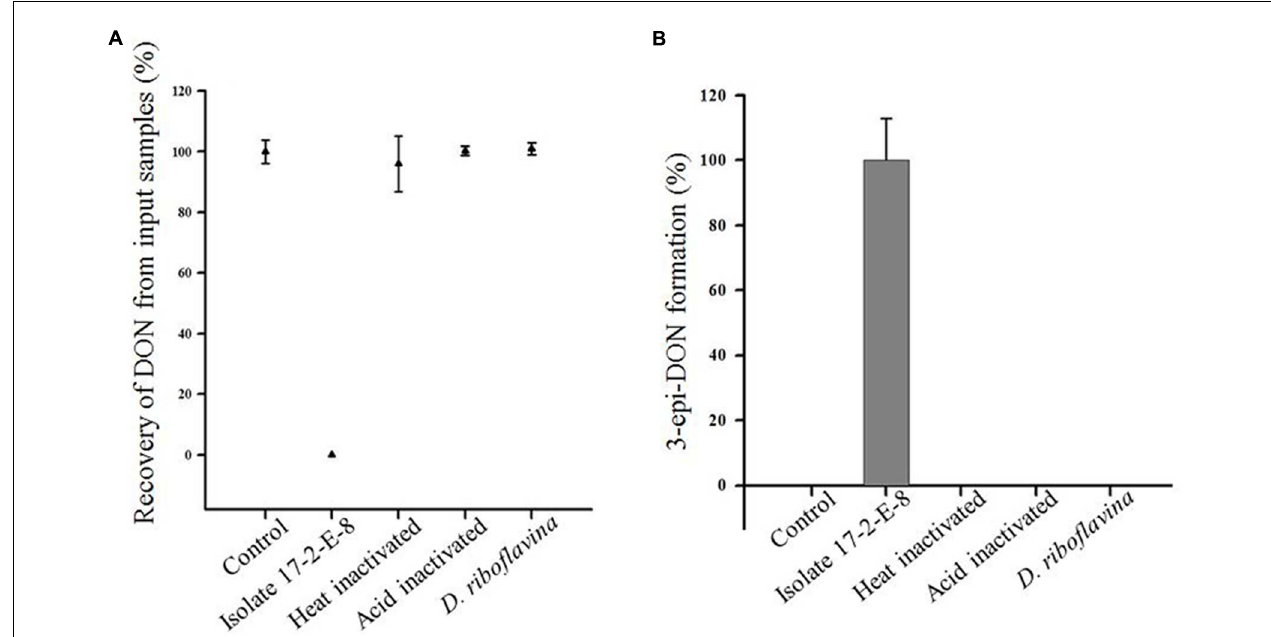
FIGURE 2 | Recovery of DON (A) and production of 3-epi-DON (B) by viable cells of isolate 17-2-E-8. Neither heat nor acid-inactivated cells showed the same tendency. The accumulation of 3-epi- DON was a characteristic of isolate 17-2-E-8 compared to Devosia riboflavina Strain IFO13584.